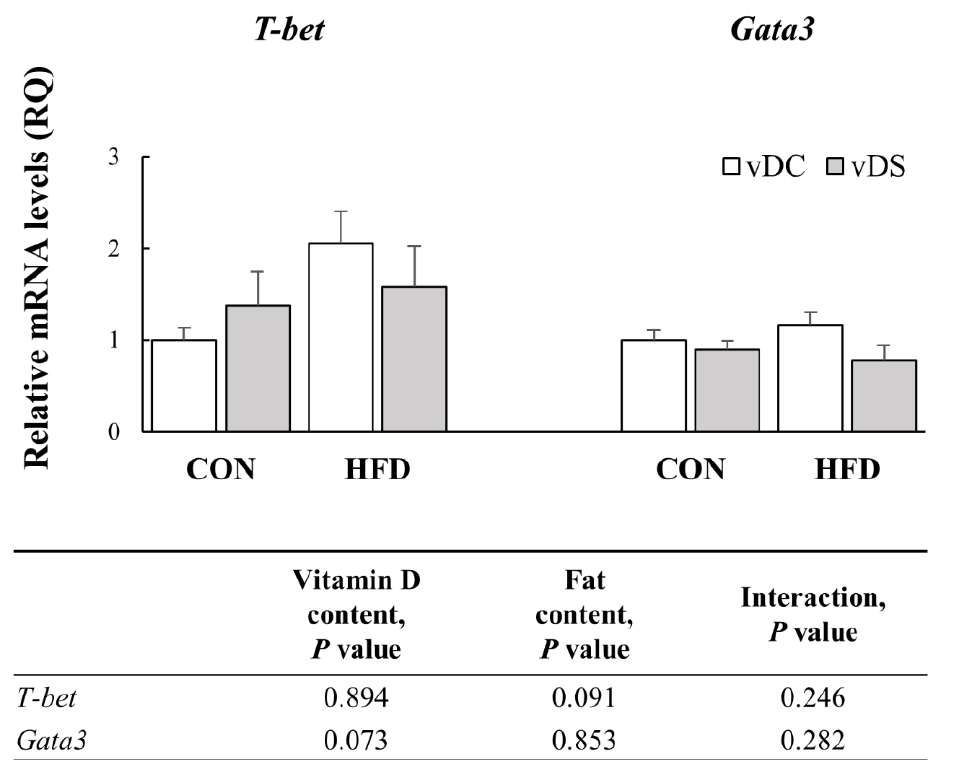
Figure 6. mRNA levels of T-bet and Gata3 in T cells. Splenic T cells were stimulated with anti- CD3/anti-CD28 mAbs for 48 h, and the mRNA levels of T-bet and Gata3 were determined by qPCR. Data are presented as means ± SEMs, n = 7–9 per group. Two-way ANOVA was used to determine the significant effects of fat and vitamin D contents, and an interaction. All values were normalized to the levels of housekeeping gene Gapdh and expressed as relative mRNA levels compared with the average levels of the CON-vDC group. CON-vDC, 10% kcal fat diet + vitamin D control; CON-vDS, 10% kcal fat diet + vitamin D supplemented; HFD-vDC, 45% kcal fat diet + vitamin D control; HFD-vDS, 45% kcal fat diet + vitamin D supplemented.